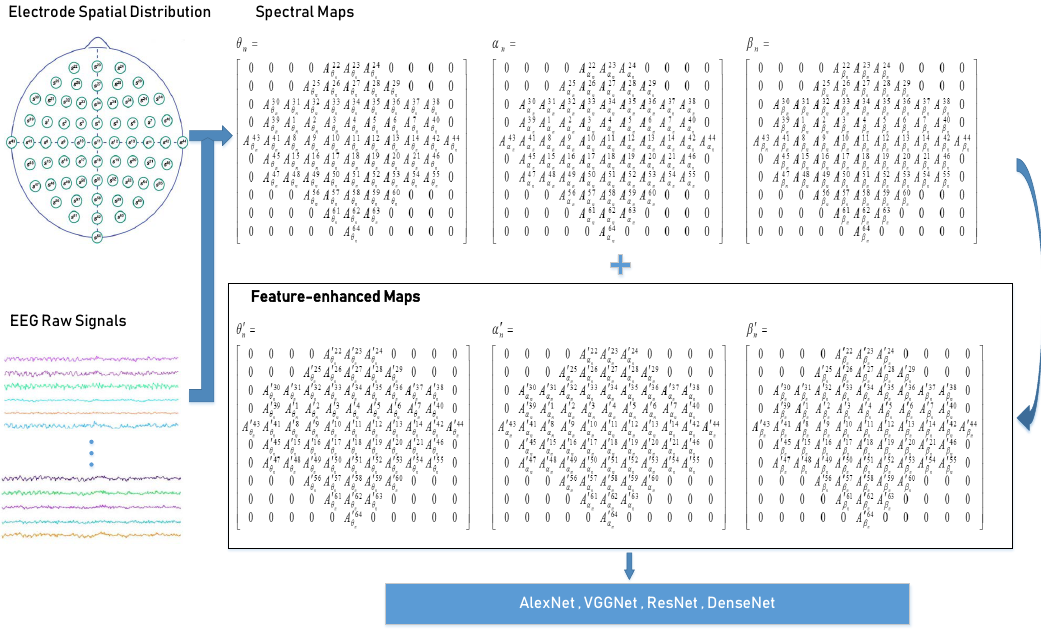
. . . A 64 , A 1 α . . . A 64 α , A 1 . . . A 64 represent the spectral values θ n β n θ n β n n n